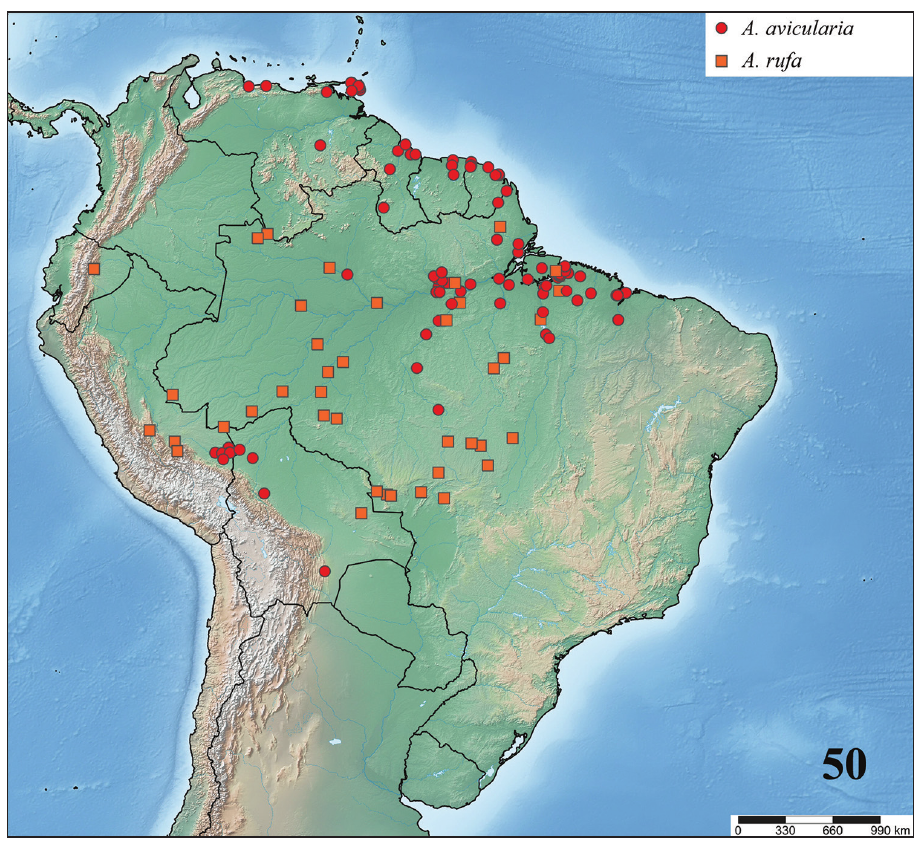
Figure 50. Map showing records of Avicularia avicularia (Linnaeus, 1758) and Avicularia rufa Schiapelli & Gerschman,